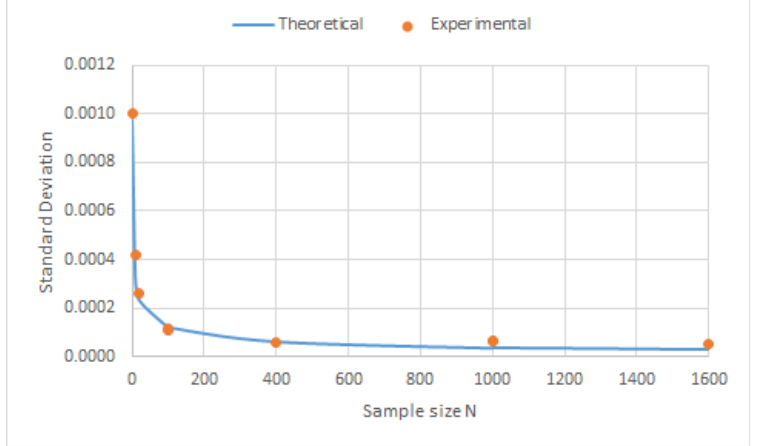
Figure 13. Standard deviation values as a function of the sizes of the sample mean.